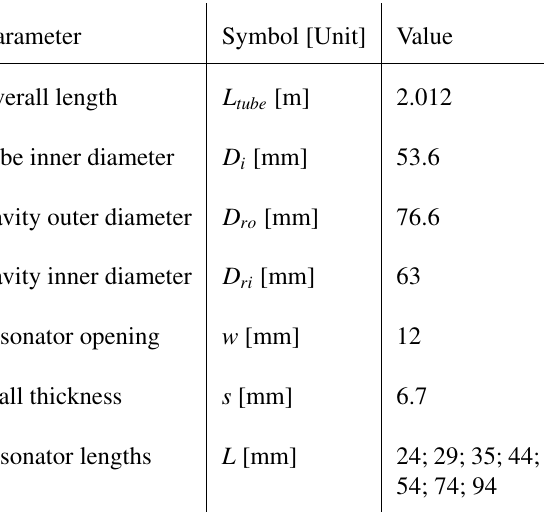
Table 1. Summary of dimensions